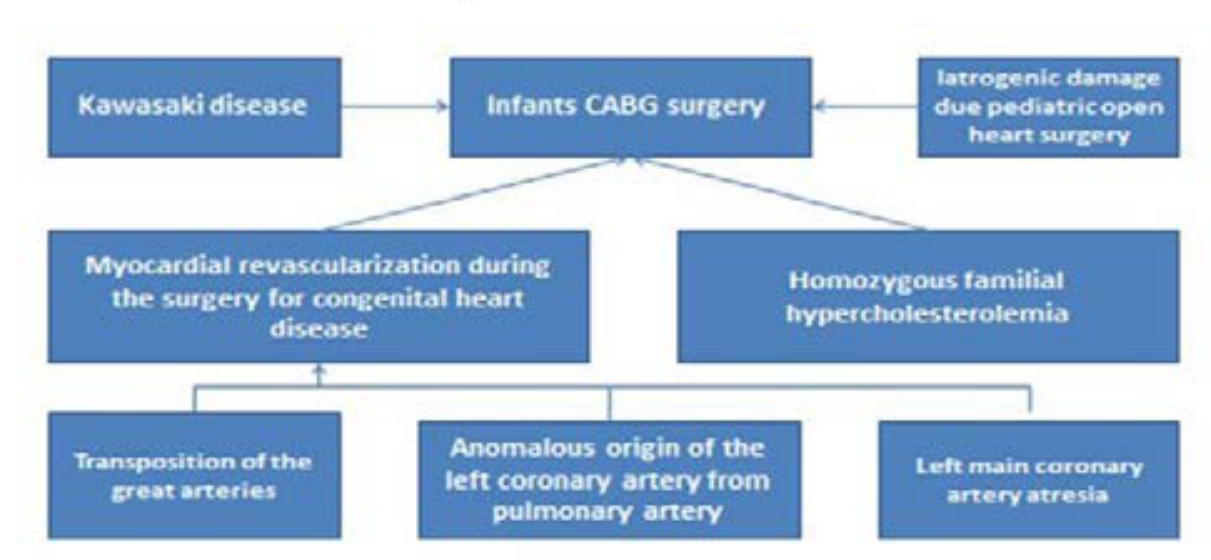
Fig. 1 – Main indications for pediatric coronary artery bypass grafting (CABG) surgery. LCA=left coronary